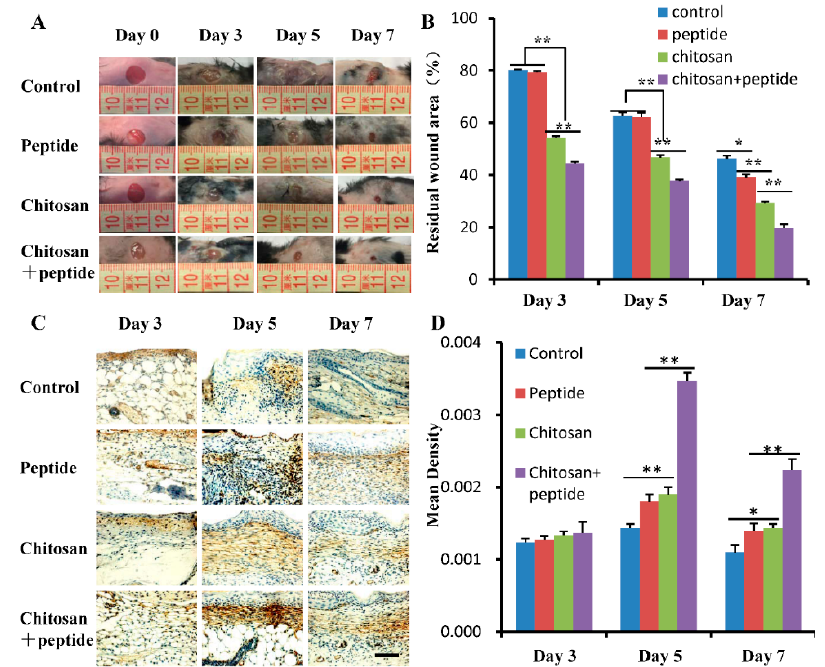
Figure 1. A SIKVAV-modified chitosan hydrogel promotes the contraction of skin wounds in mice: ( A ) Typical photoimages of the general wounds of control, SIKVAV, chitosan, and SIKVAV-modified chitosan group mice on days 3, 5, and 7 after trauma. ( B ) Statistical analysis of the residual wound percentage of mice in the control, SIKVAV, chitosan, and SIKVAV-modified chitosan groups ( n = 6, * p < 0.05, and ** p < 0.01). ( C ) Immunohistochemistry showing the expression of α -SMA in the skin wounds of the control, SIKVAV, chitosan, and SIKVAV-modified chitosan group mice on days 3, 5 and 7 after trauma (scale bar: 50 µ m). ( D ) Statistical analysis of α -SMA in the skin wounds of mice in the control, SIKVAV, chitosan, and SIKVAV-modified chitosan groups on days 3, 5 and 7 after trauma ( n = 3, * p < 0.05, and ** p < 0.01).